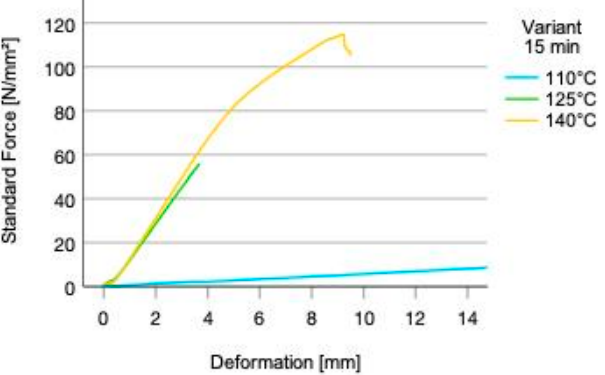
Figure 7. Stress-deformation behavior of selected samples for 15 min press time and three different temperatures.